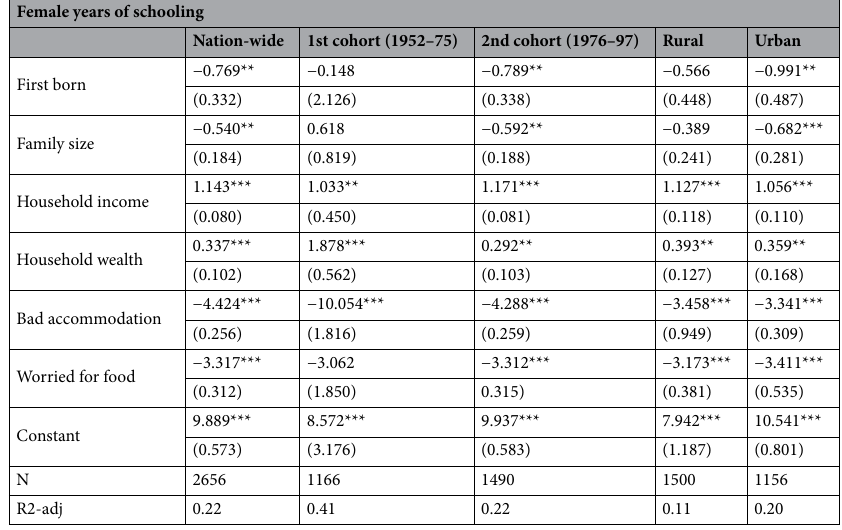
Table 2. The effect of female(daughter) birth order on own education attainment. Robust standard errors are shown in parenthesis *p < 0.10, **p < 0.05, *** <